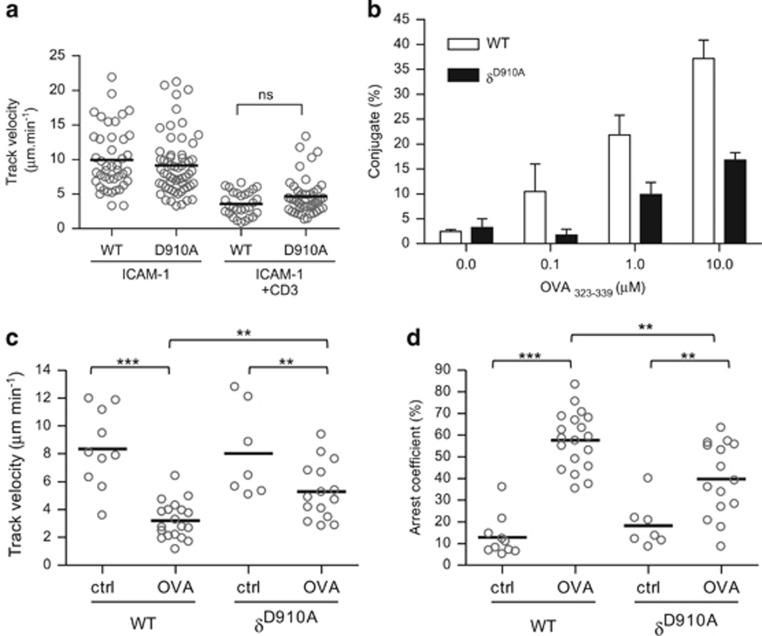
Inhibition of p110δ disrupts T cell-APC conjugate formation. (a) WT and p110δD910A CD4+ T-cell blasts were loaded onto surfaces coated with ICAM-1 alone or with ICAM-1 and anti-CD3 and imaged by video microscopy for 10 to 15 min. Cell movements were analysed by Volocity software. Data are representative of three independent experiments. (b) WT and p110δD910A OT2 CD4+ T-cell blasts were incubated with OVA323-339-loaded APC for 30 min and assessed for conjugate formation as described in Methods. (c–d) p110δD910A T cells do not slow down as much as the WT when presented antigen by the APC. Data show means of the velocity (c) and arrest coefficient (d) of WT and p110δD910A OT2 CD4+ T-cell blasts during their interaction with APC in presence or absence of OVA323-339 peptide. Data are the mean values of three independent experiments.